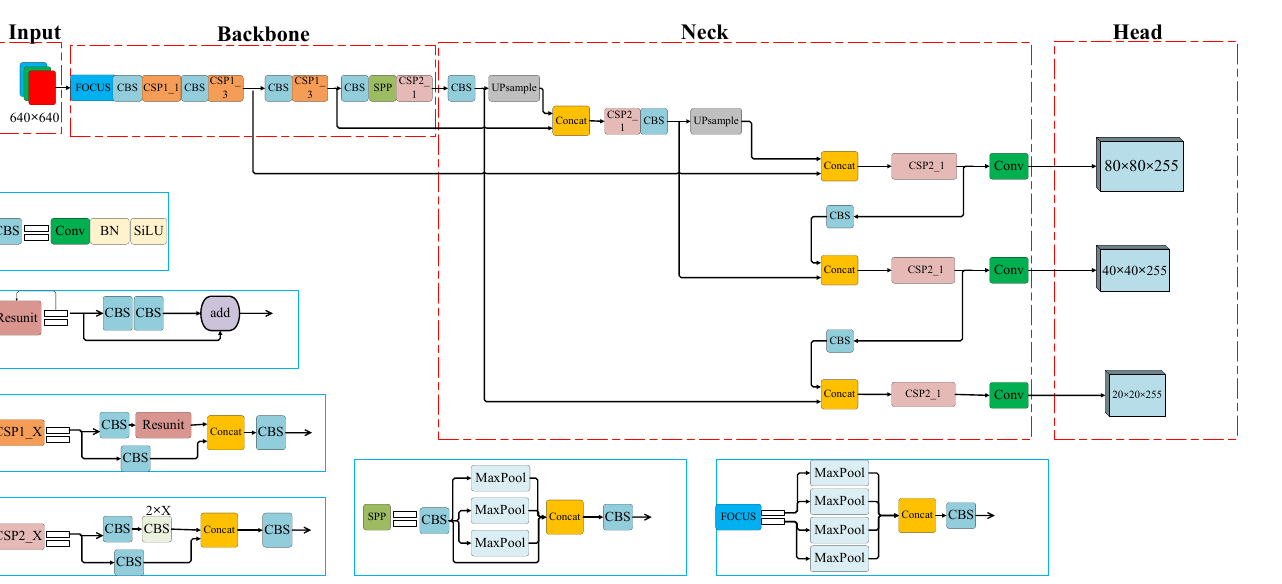
Figure 3. The structure of the YOLOv5s model.